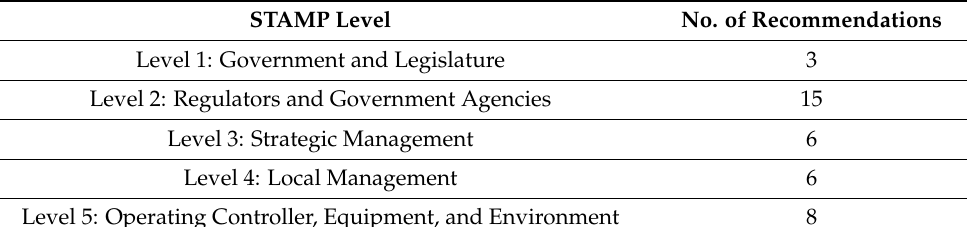
Table 4. Number of Recommendations Identified at each STAMP Level.